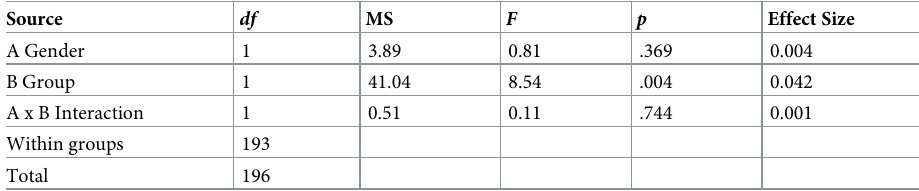
Table 5. ANOVA summary table for pain.